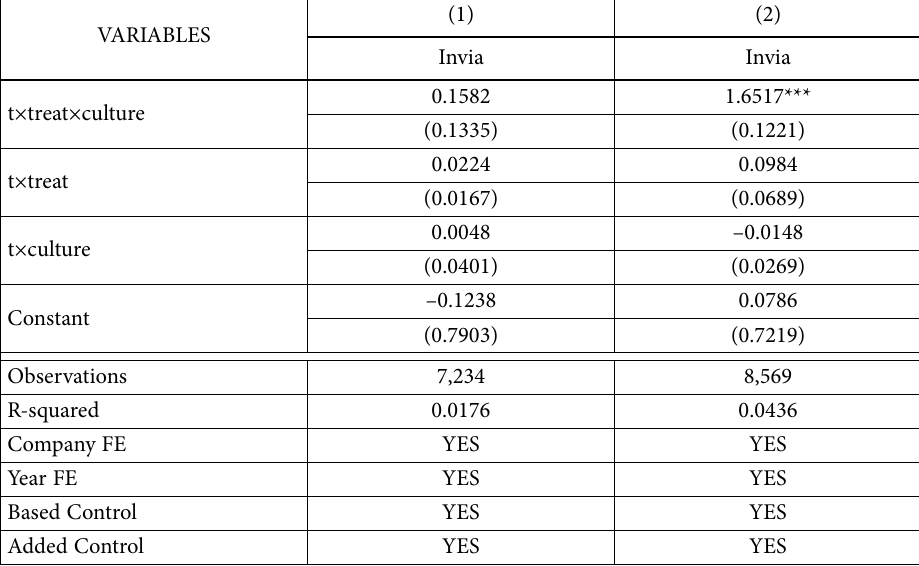
Table 8. Multinational and non-multinational